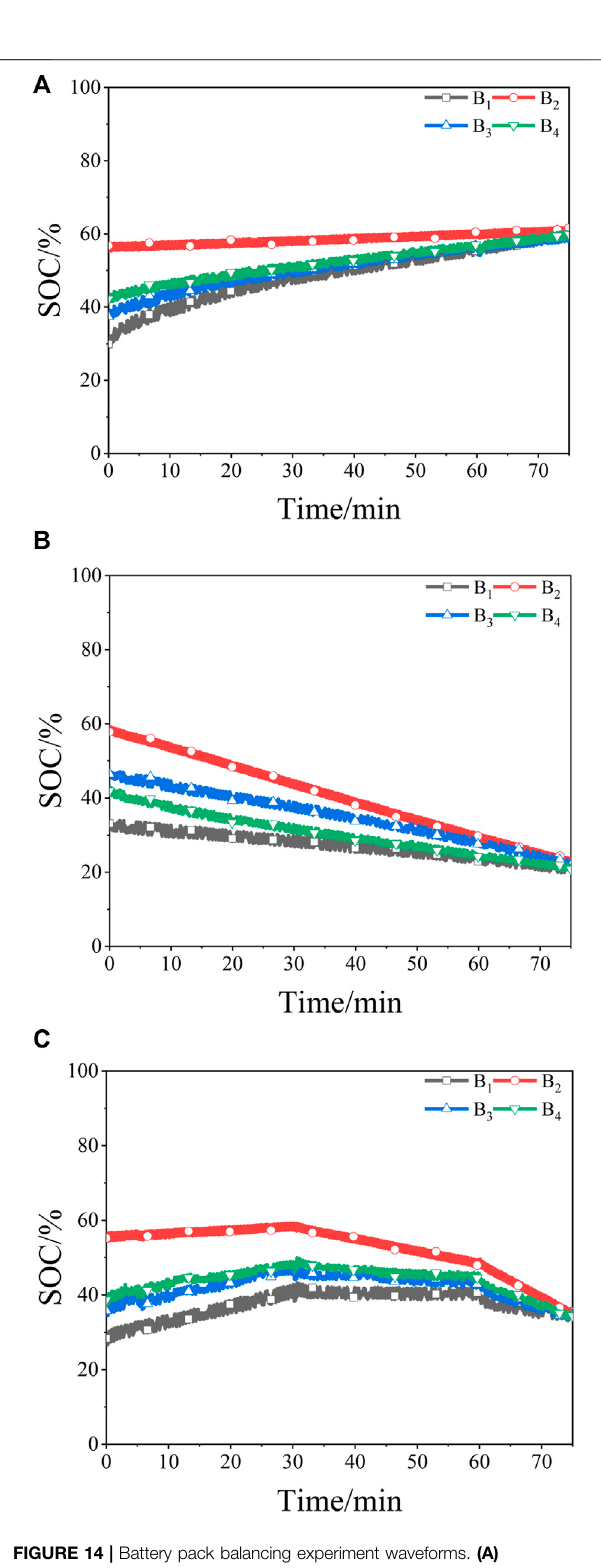
FIGURE 14 | Battery pack balancing experiment waveforms. (A) Equalization of the battery pack charging process. (B) Equalization of the battery pack discharging process. (C) Dynamic